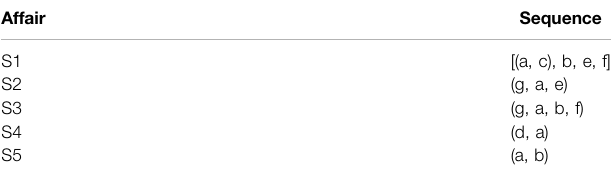
TABLE 1 | Serial transaction database.